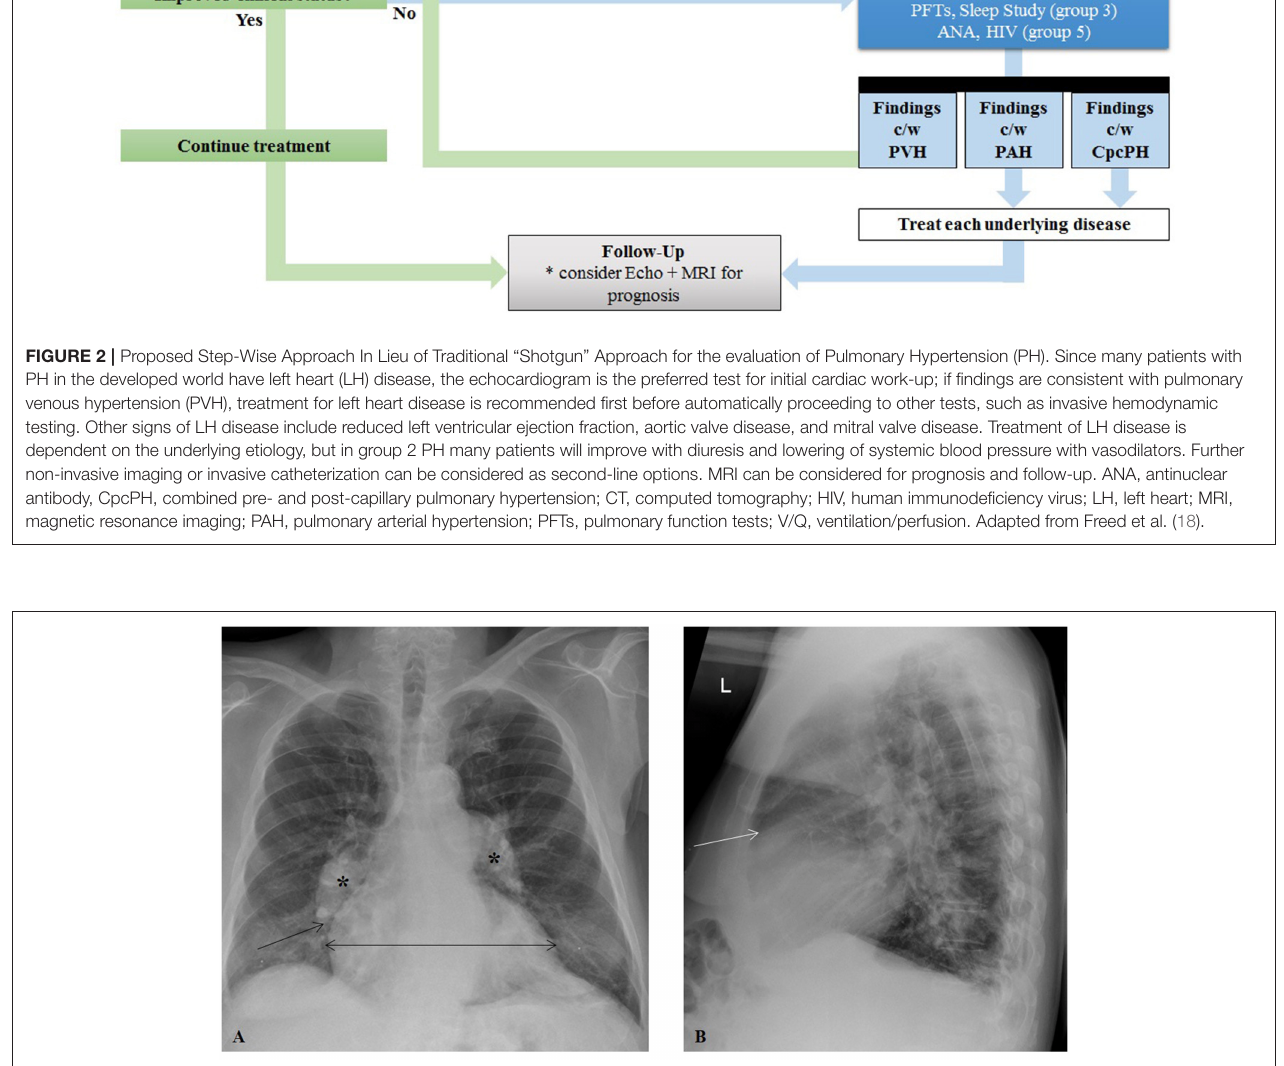
FIGURE 3 | Chest radiography in a patient with groups 2 and 3 pulmonary hypertension. (A) Posteroanterior projection illustrating prominent, dilated central pulmonary arteries (asterisks), cardiomegaly (horizontal line), and rapid tapering (pruning) of right pulmonary artery (arrow). (B) Lateral projection showing a decrease in the retrosternal air space